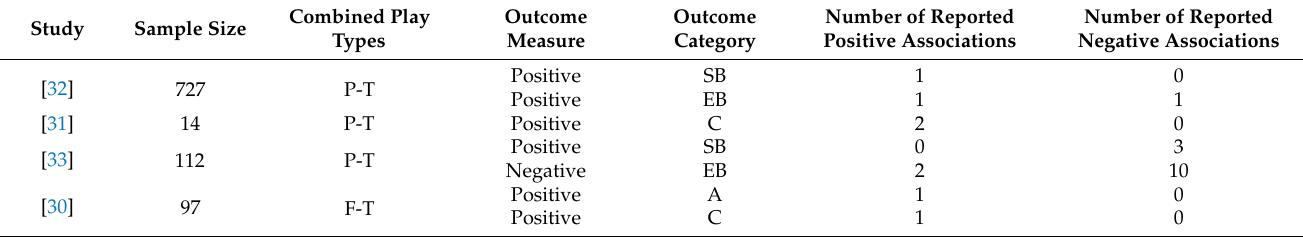
Table 3. Combined play—outcome measure descriptions and results